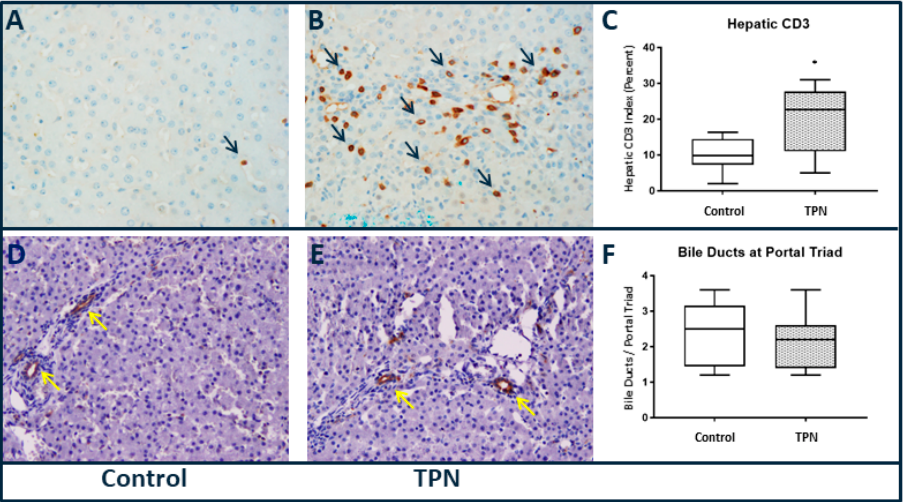
Figure 3: Liver immunohistochemistry, 40× magnification (A–C) cluster of differentiation 3 (CD3) and (D–F) cytokeratin 7 (CK-7). Significantly higher CD3 staining was found with TPN. No differences in CK-7 staining of bile ducts were found. Histology scoring was performed, and a pairwise Mann– Whitney U test was conducted to determine p -value. All tests were two-sided, using a significance level of 0.05.